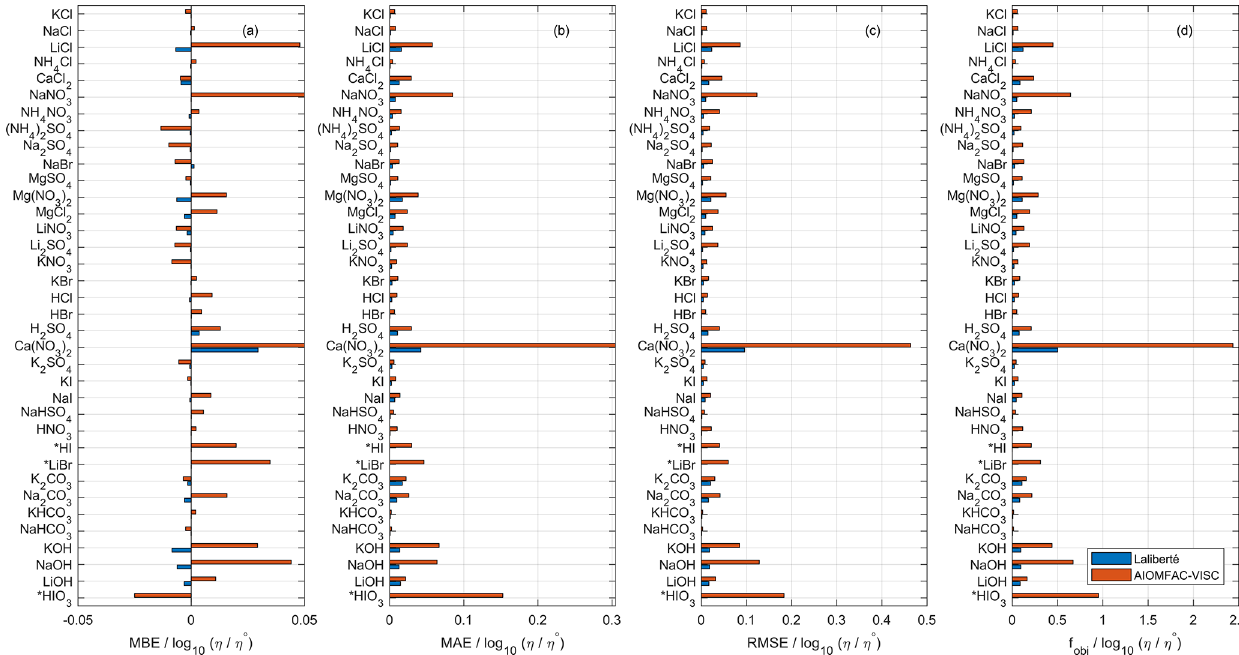
Figure 1. Comparison of AIOMFAC-VISC and the Laliberté model in terms of (a) mean bias error, (b) mean absolute error, (c) root mean square error, and (d) custom objective function value used to fit AIOMFAC-VISC. See Table 2 for information on number of data points, the ranges of temperature, concentration, and viscosity for each data set. η ◦ denotes unit viscosity (1Pas). Starred entries (HI, LiBr, and HIO 3 ) were not fitted by the Laliberté model so a model–model comparison is not